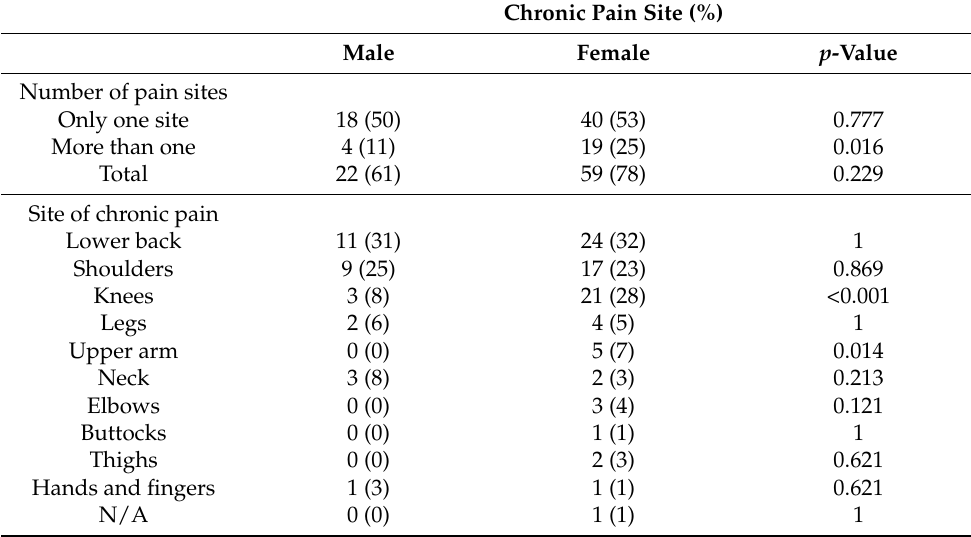
Table 2. Prevalence of chronic pain in different body regions between males and